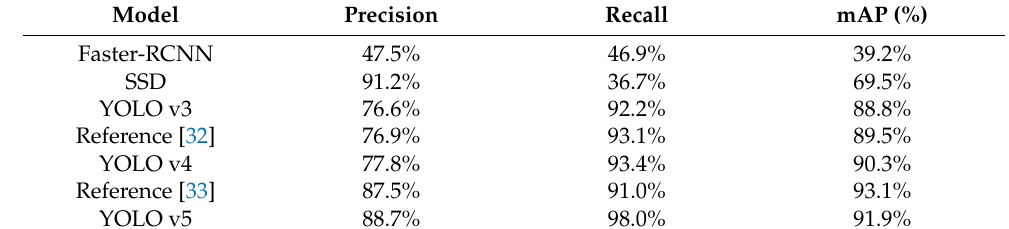
Table 4. The results of wheat ear detection based on different methods.